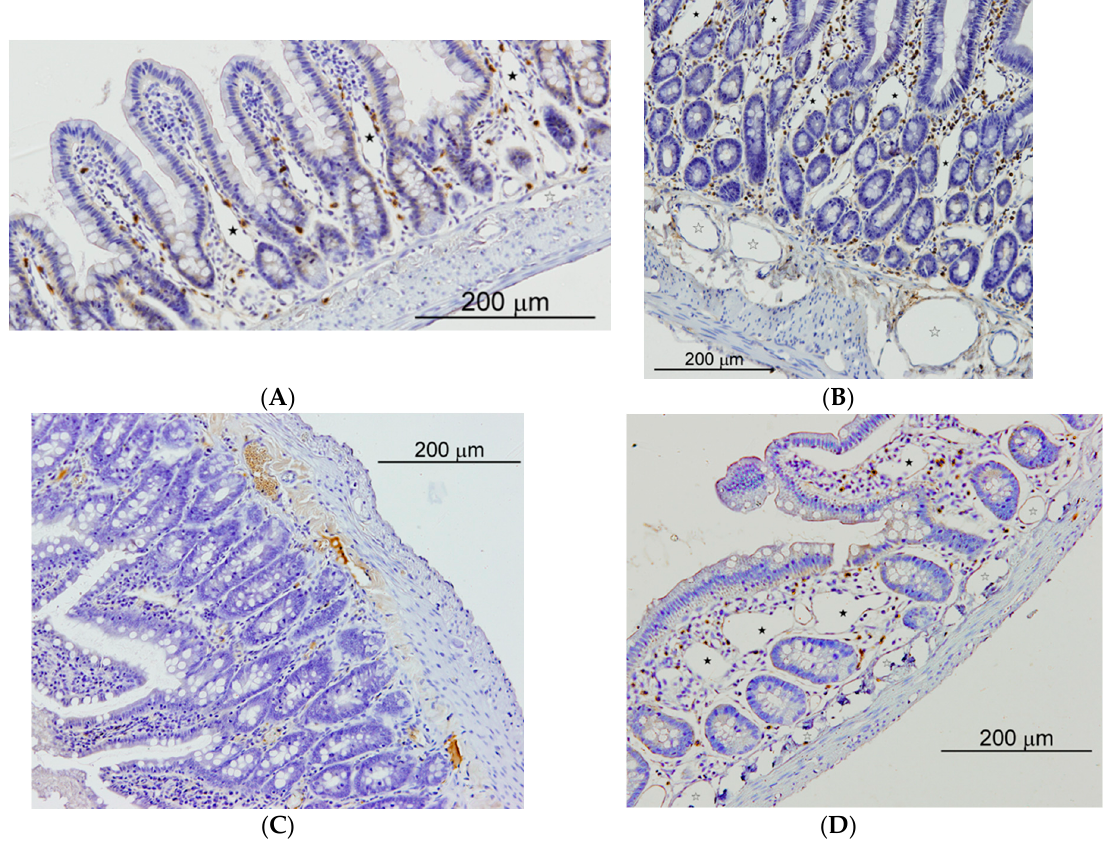
Figure 5. Small intestine of sham operated (SO) and microsurgical cholestatic-rats (MC) immunostained with rabbit polyclonal anti-LYVE-1, dilution 1:500 (Abcam; Cambridge, UK), a specific marker of lymphatic endothelium. ( A ) image of a duodenum SO-rat: some small lymphatics lumen are observed in the villi axis that are scarcely enlarged (full star); ( B ) duodenum from a rat with MC: abundant and enlarged lymphatics are observed either in the mucosa (full stars) as in the submucosa (empty stars); ( C ) Image of an ileum SO-rat: any lymphatic lumen is observed in the villi; ( D ) ileal image from an animal with MC showing a relevant enlargement of lymphatic microvessels either in the mucosa (full stars) as in the submucosa (empty stars). The size of the calibration bars throughout all images was 200 µm.